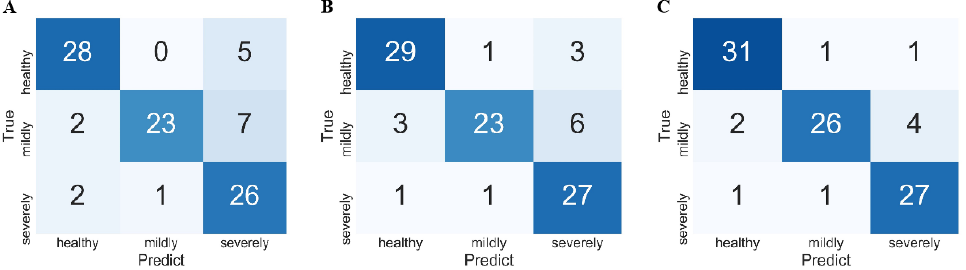
Figure 4. Confusion matrix of RF ( A ); GBDT ( B ); SVM ( C